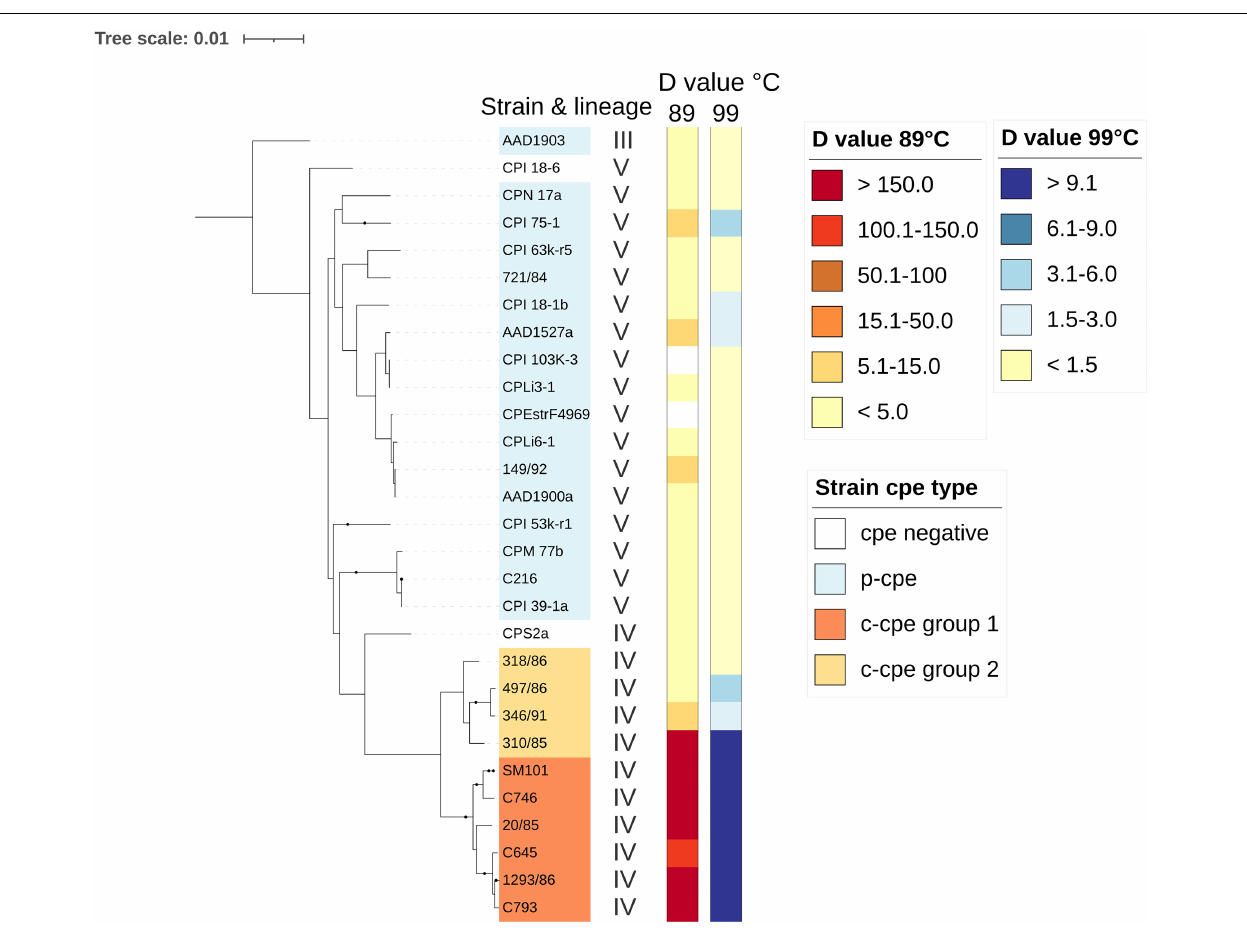
These comparisons revealed a cluster of 5 genes present in heat resistant strains (CPR_0713-0717) but absent from heat-sensitive c-cpe strains. Genes in this cluster encode for CoA-disulfide reductase NaoX and related permease and putative transcriptional regulator ( Figure 3 ). Additionally, heat-sensitive c-cpe strains had lost a copy of GraRS two-component system, and type IV pilus operon genes pilW , pilA , and pulG were resistant c-cpe strains.